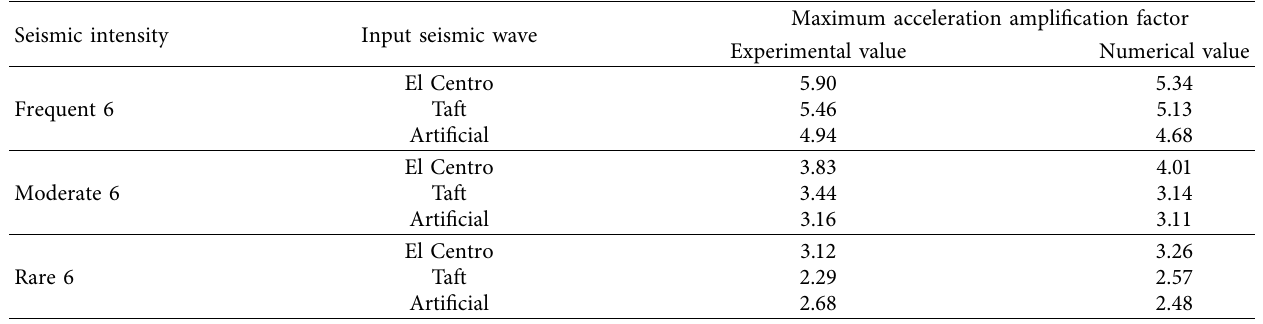
Table 12: Comparison of maximum acceleration amplification factor in the Y